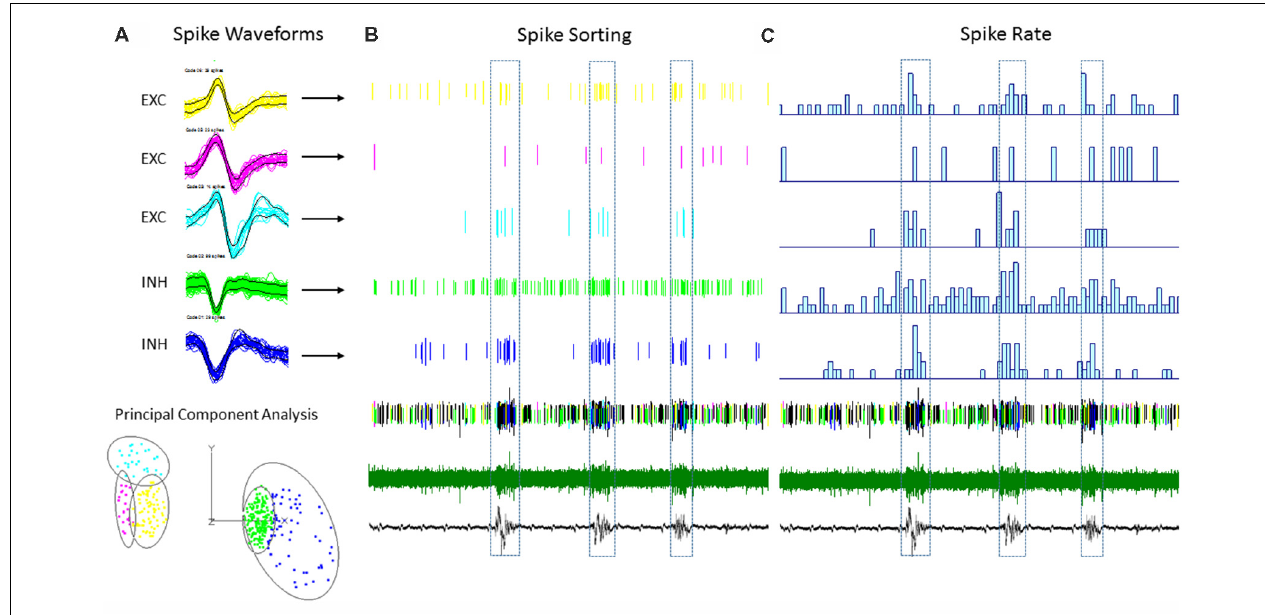
FIGURE 7 | An example of single-unit activities (SUAs) sorting during the B-S activities in a FL mouse. (A) Five (SUAs, three EXCs and two INHs) were shown from a single linear electrode recording. The spike amplitude and duration of these SUAs formed two separate large clusters using principal component analysis, INHs and EXCs are clustered together. (B) Raster plot showing the spike time of each spike aligned to the B-S LFPs. (C) The spike rate plotted on top of the LFPs. The spike rates are higher for all SUAs during the bursts